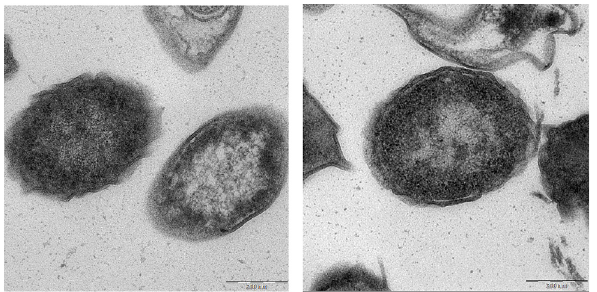
Fig 3. TEM Morphological changes. Ultrastructure and morphological changes of (A) S . aureus ATCC 25923 and (B) MRSA BAA-1720 exposed to the MIC of artonin E for 24 hours showing peripheral cell surface, hollow formation and cell disintegration (bar =